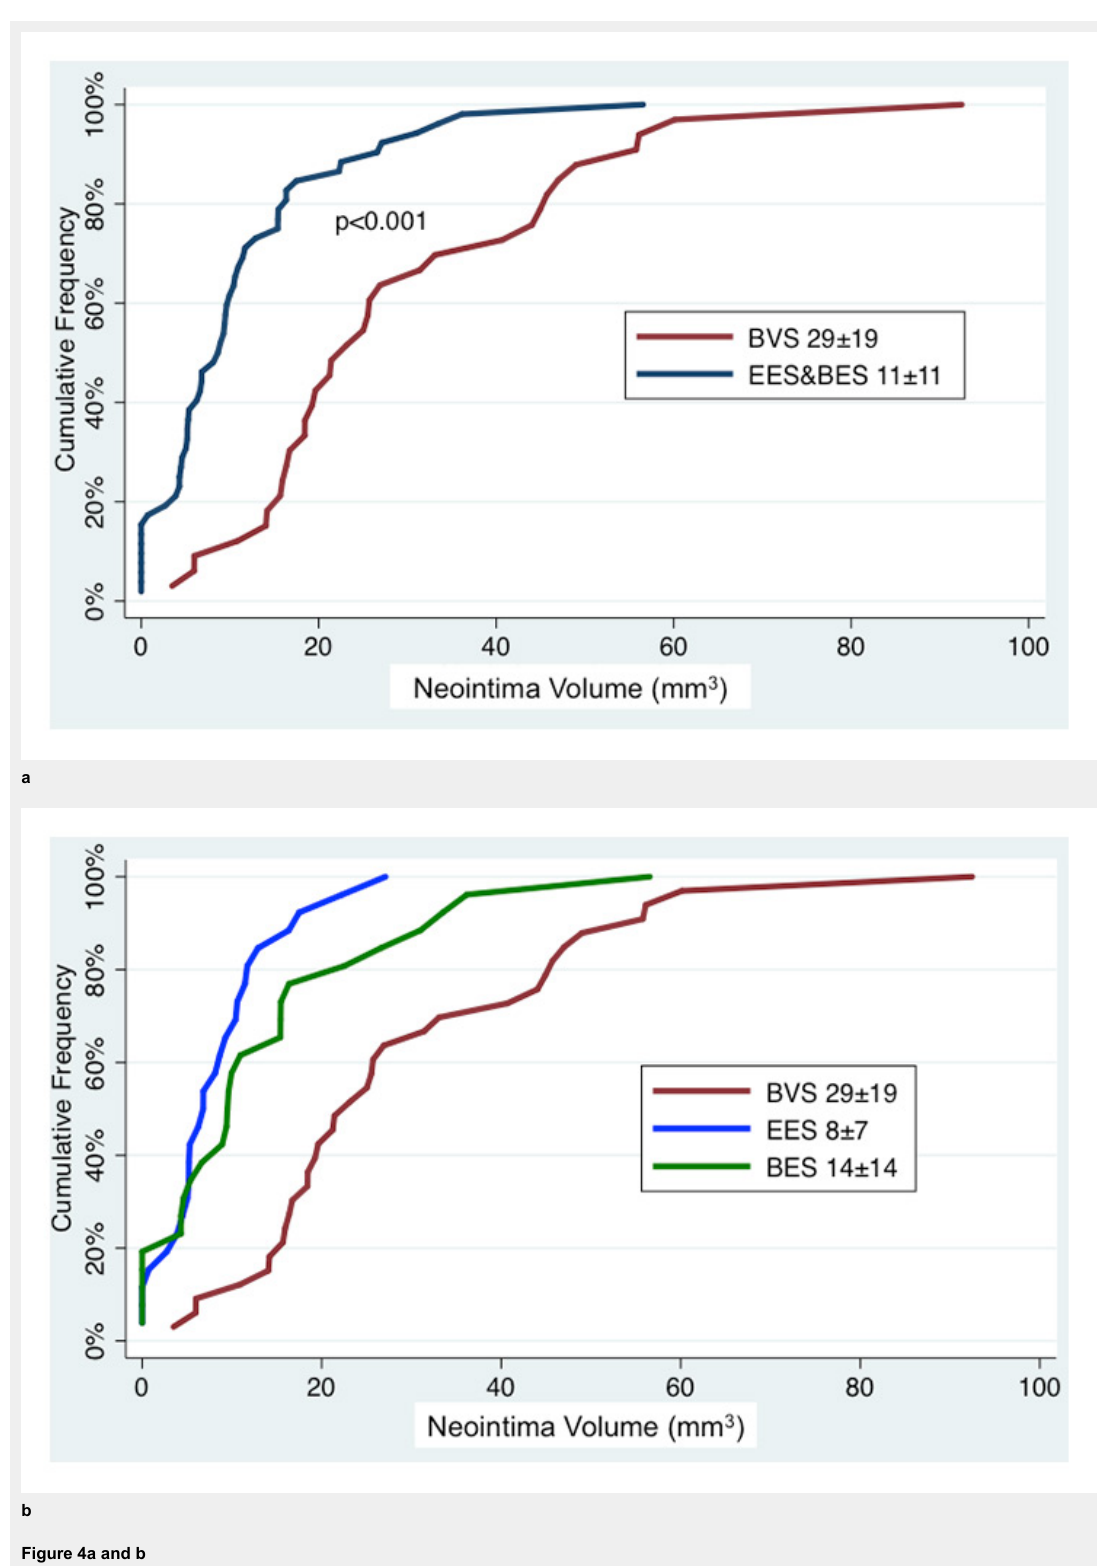
Figure 4a and b Cumulative frequency distribution of mean neointima volume at 9 months. The numbers provided are mean ± standard deviation. BES = biolimus-eluting stent; BVS = bioresorbable vascular scaffold; EES = everolimus- eluting